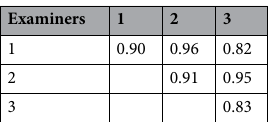
Table 2. Intra- and inter-examiner agreements for the subjective image